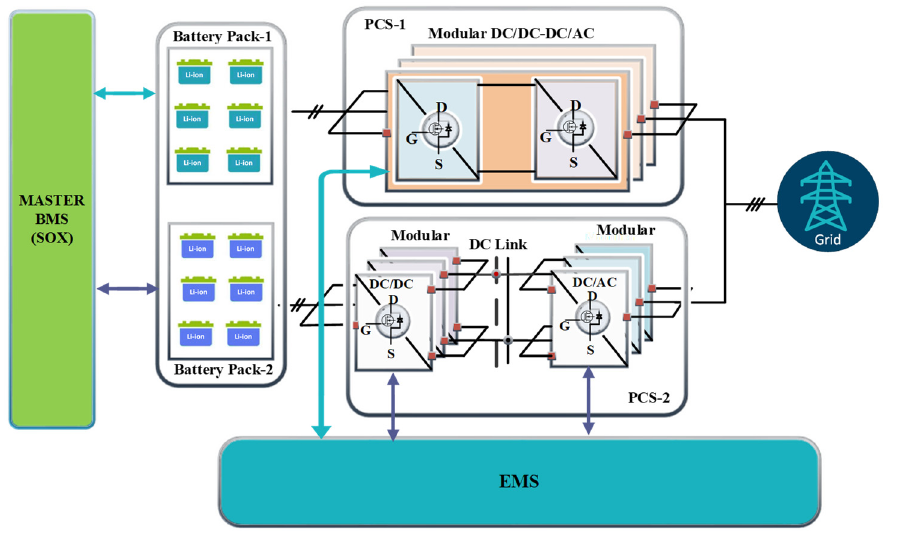
Figure 1. Principle schematic of the considered HBESS. Table 1. Notations used to define the size of